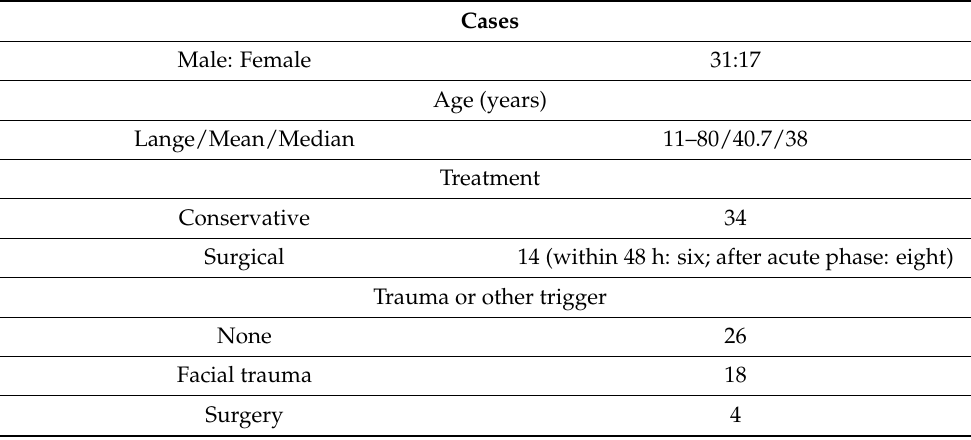
Table 1. Characteristics of reported patients with orbital emphysema due to nose-blowing.